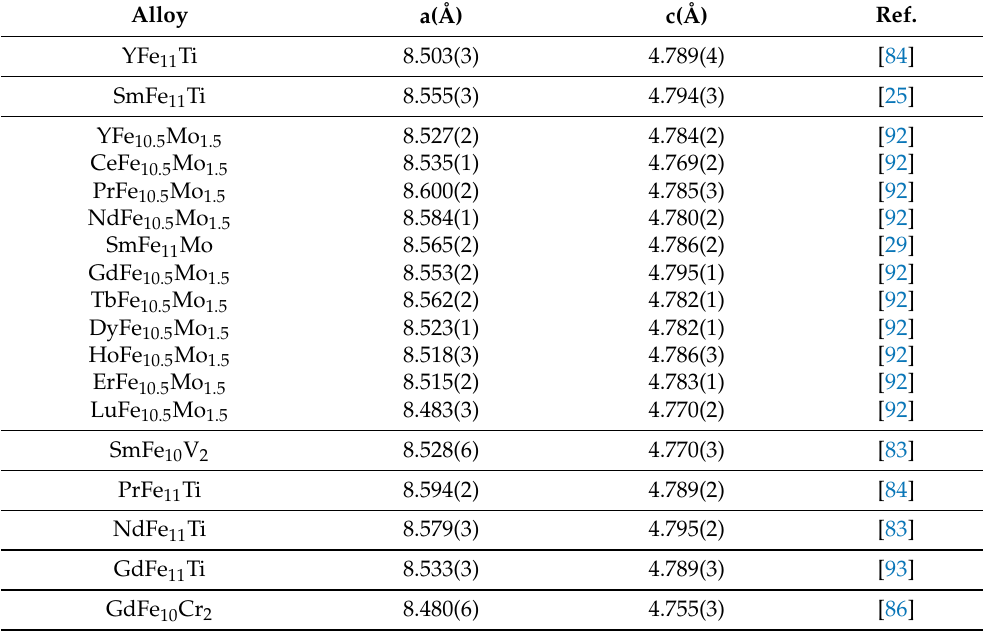
Table 5. XRD analysis results obtained by Rietveld method on the R Fe 12 − x M x ( M = Si, Ti, Cr, V, Cr, Mo) and ( x = 0, 0.5, 1, 1.5, 2) alloys